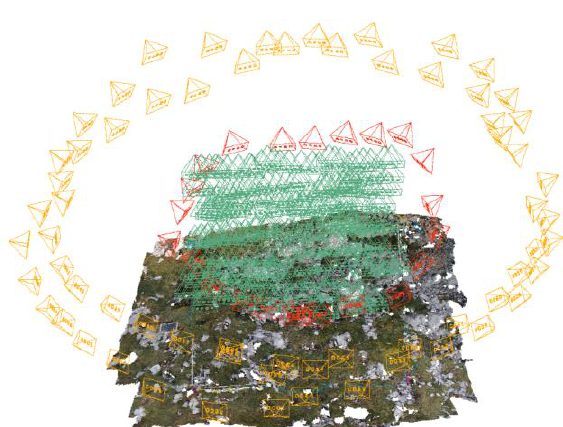
Figure 5. Vertical and oblique camera positions around a plot